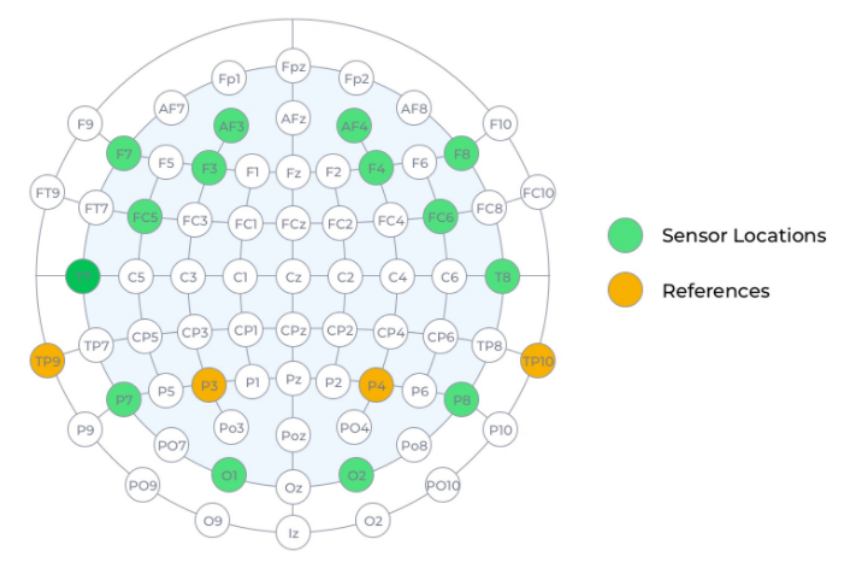
Figure 2. The layout of the electrodes on the